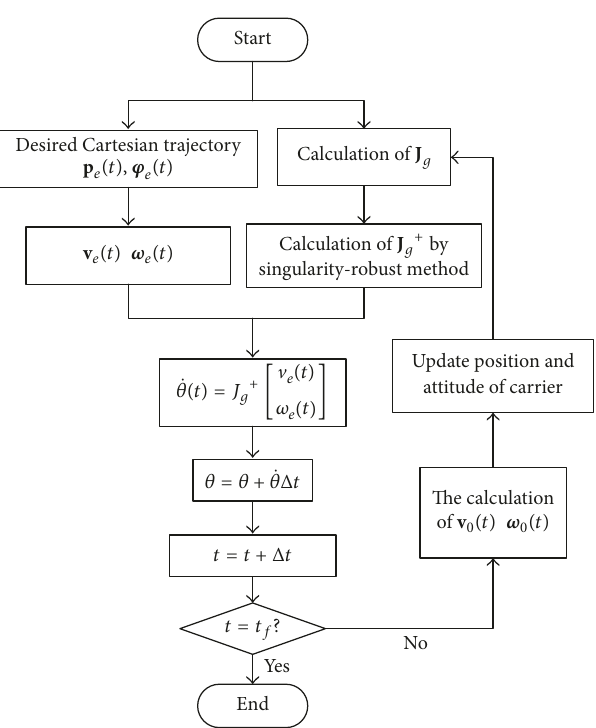
Figure 2: Calculation flow chart of the Cartesian path planning for free-floating space